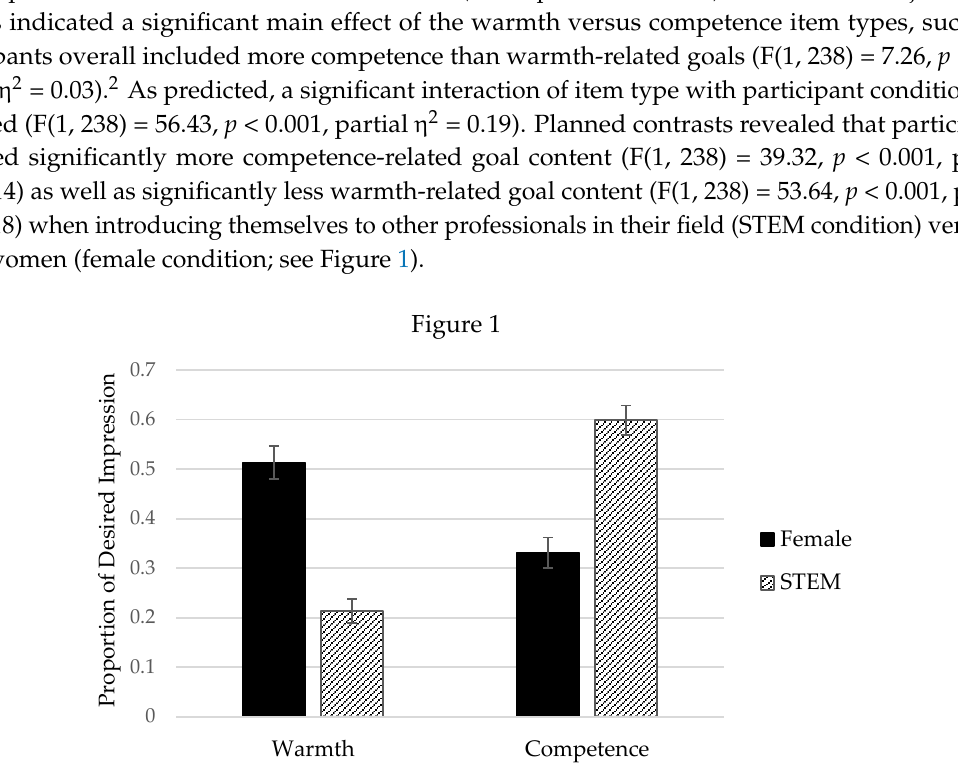
Figure 1. Proportions of Desired Impressions Coded as Warmth and Competence. Error bars represent standard errors.